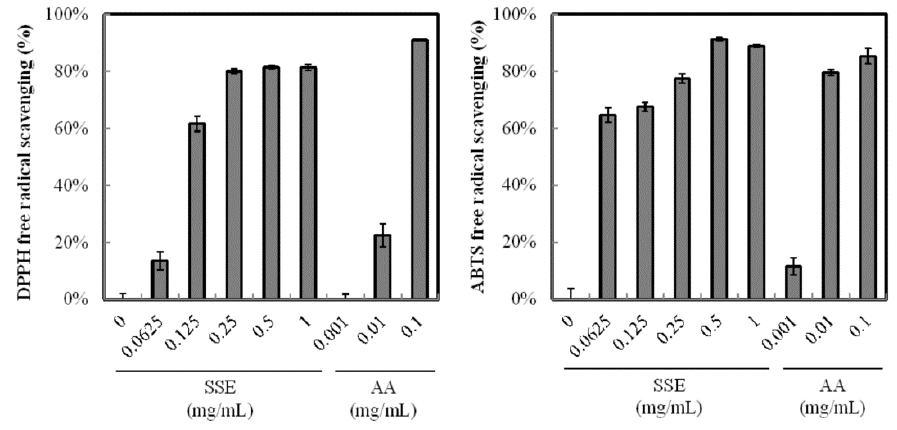
Figure 1. Antioxidant activity of SSE. Radical scavenging capability was measured by the DPPH and ABTS+ method. Ascorbic acid (AA) was used as positive control. Results are mean ± S.D. ( n = 3).